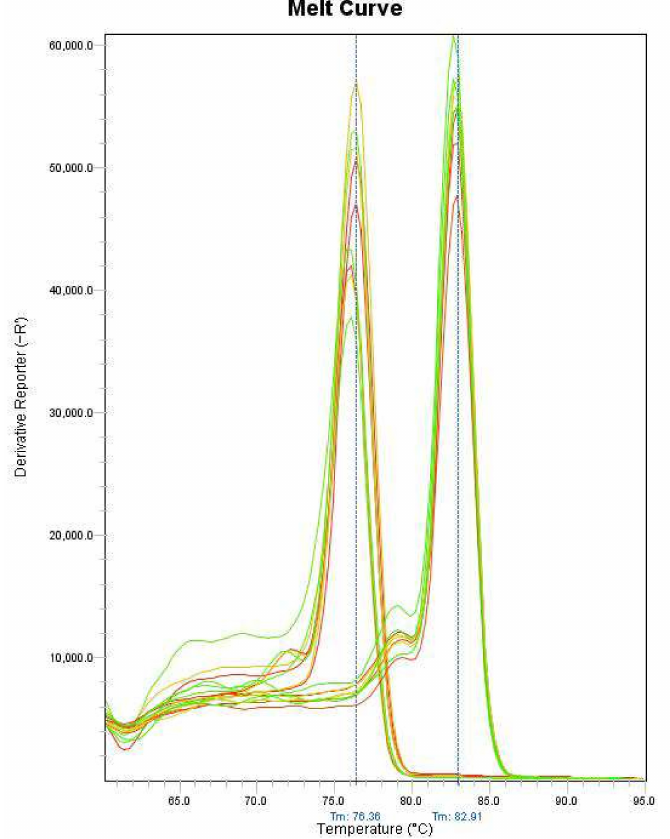
Figure 4. Conventional melting curves obtained by real-time PCR amplification targeting MRJP2 gene. Left cluster, A. cerana honey; right cluster, A. mellifera